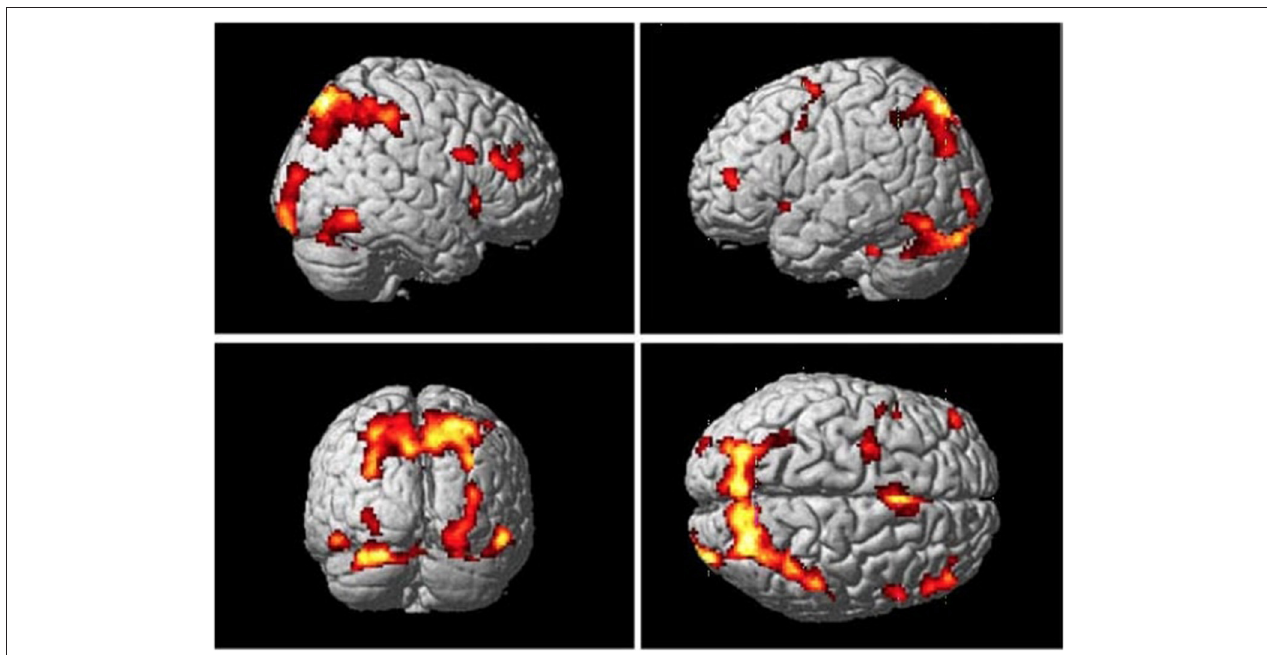
FIGURE 3 | Common brain regions that were more active while participants viewing stimuli they had recently learned by either trial-and-error exploration or observation than control stimuli at the retrieval stage. Adopted from Monfardini et al. (2008) with